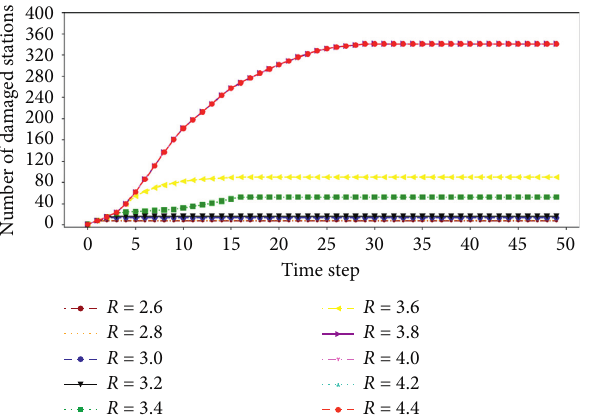
Figure 5: Network cascading failure processes caused by the Century Avenue Station under different R values of disturbance with ε � 0.2.